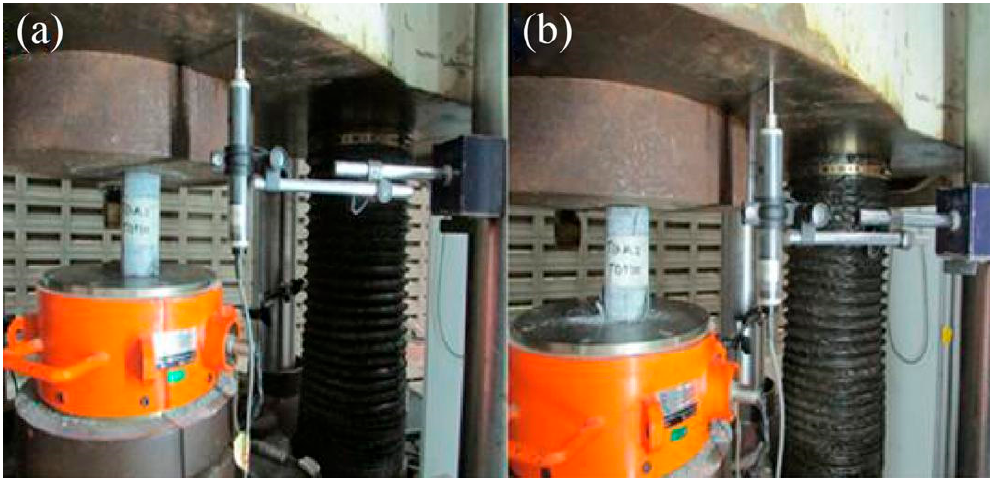
Figure 3. Uniaxial compressive strength (UCS) test conducted on a sample of TBM 2, tunnel distance = 9300 m, ( a ) before failure, ( b ) after failure.